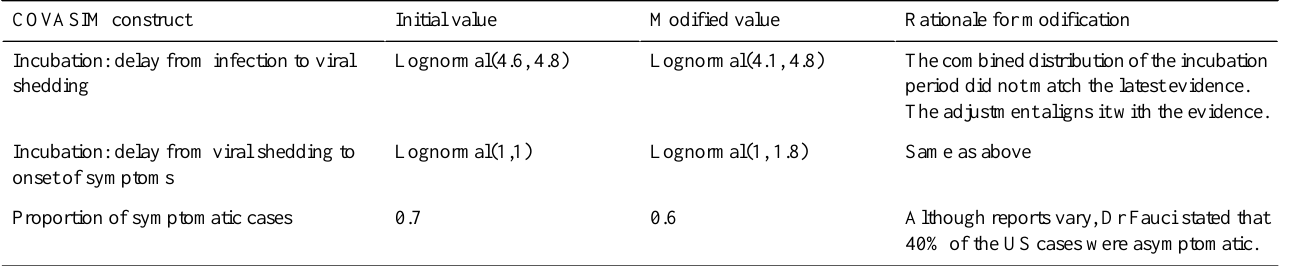
Table 1. Adjusted parameters based on reports in the United States.